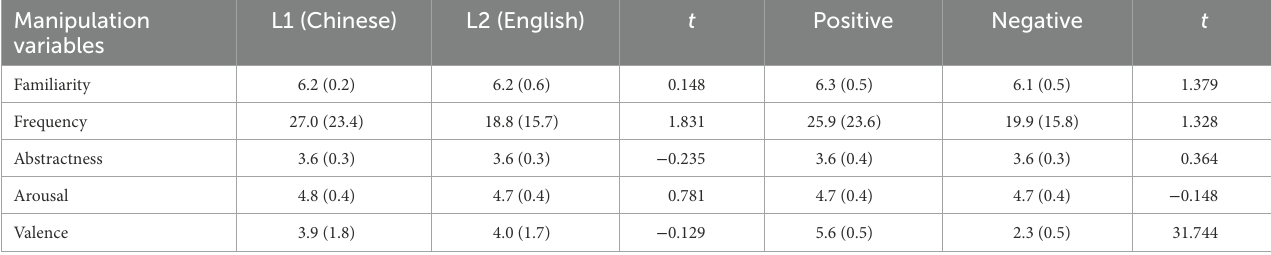
TABLE 3 Means and SDs of stimulus attributes for Chinese, English, positive and negative emotional words. Manipulation variables